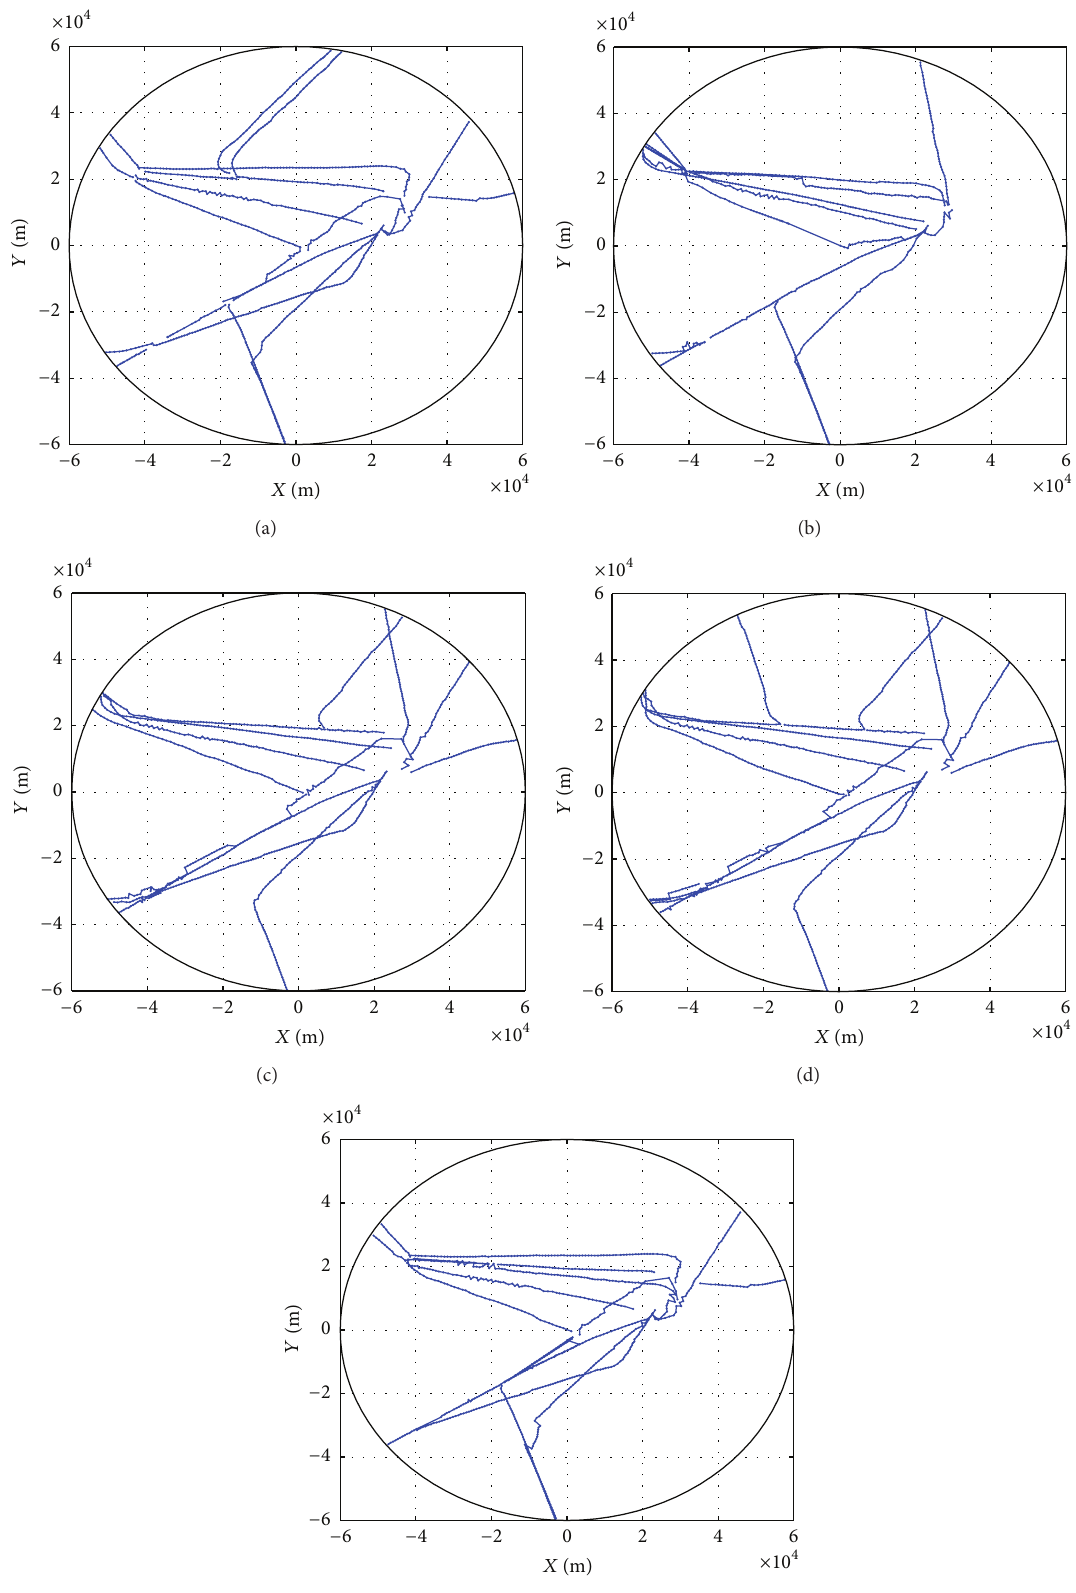
Figure 8: Clustering results for different air traffic